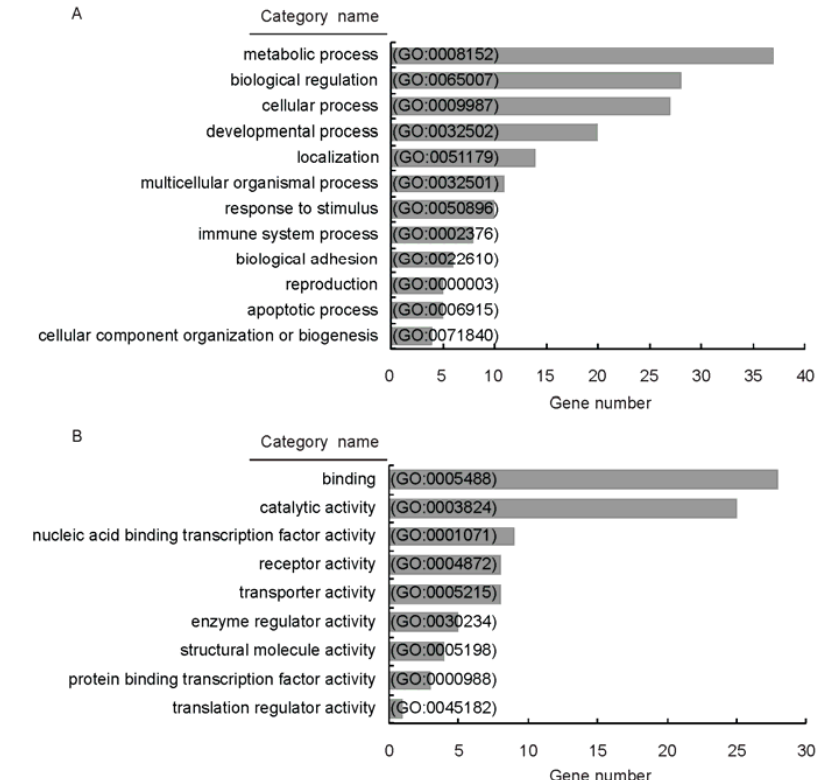
Figure 2. GO terms analysis of miR-196a biological function based on the predicted targets. ( A ) GO biological processes that were significantly overrepresented were generated from the annotations of biological processes; ( B ) GO molecular functions that were significantly overrepresented were generated from the annotations of molecular function. The target genes of miR-196a were predicted with TargetScan and PicTar, 74 overlapped targets were used for GO term enrichment analysis.